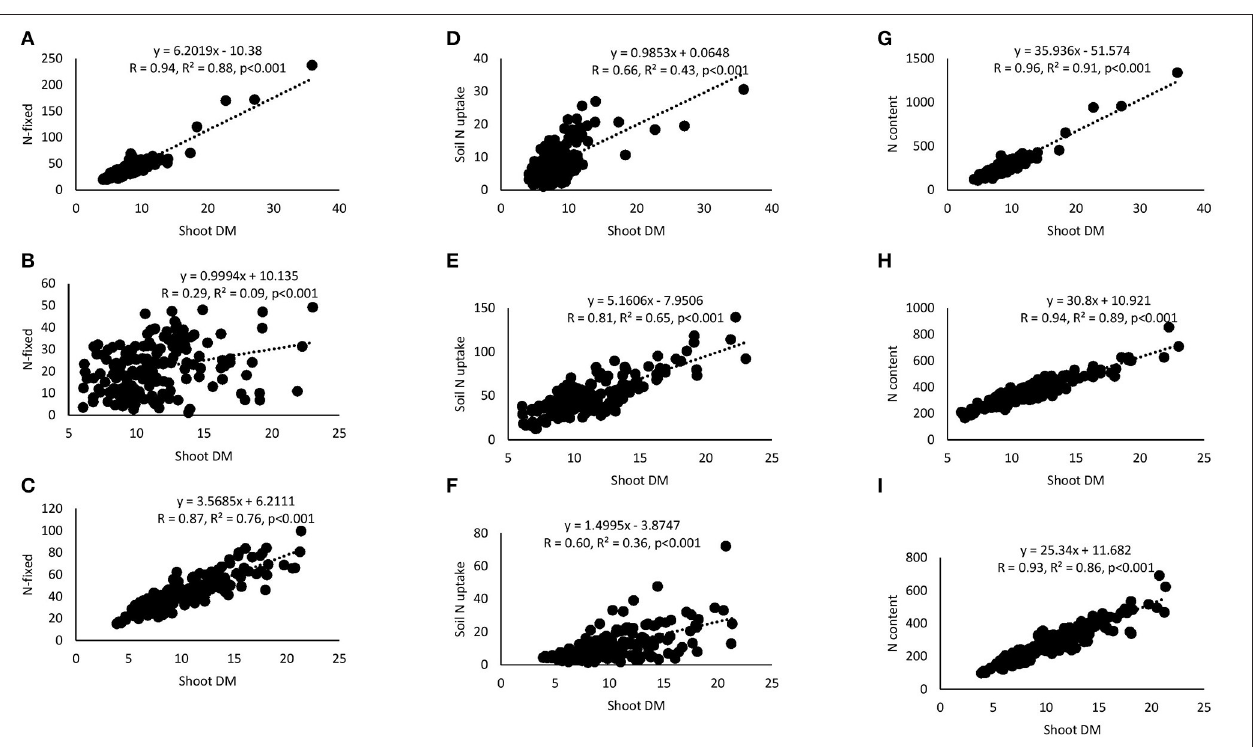
FIGURE 5 | Correlation and regression analysis between shoot dry matter (DM) and N-fixed by 15 cowpea genotypes planted in (A) Nyankpala, (B) Savelugu, and (C) Gbalahi, and between shoot DM and soil N uptake at (D) Nyankpala, (E) Savelugu, and (F) Gbalahi, and between shoot DM and N content at (G) Nyankpala, (H) Savelugu, and (I)